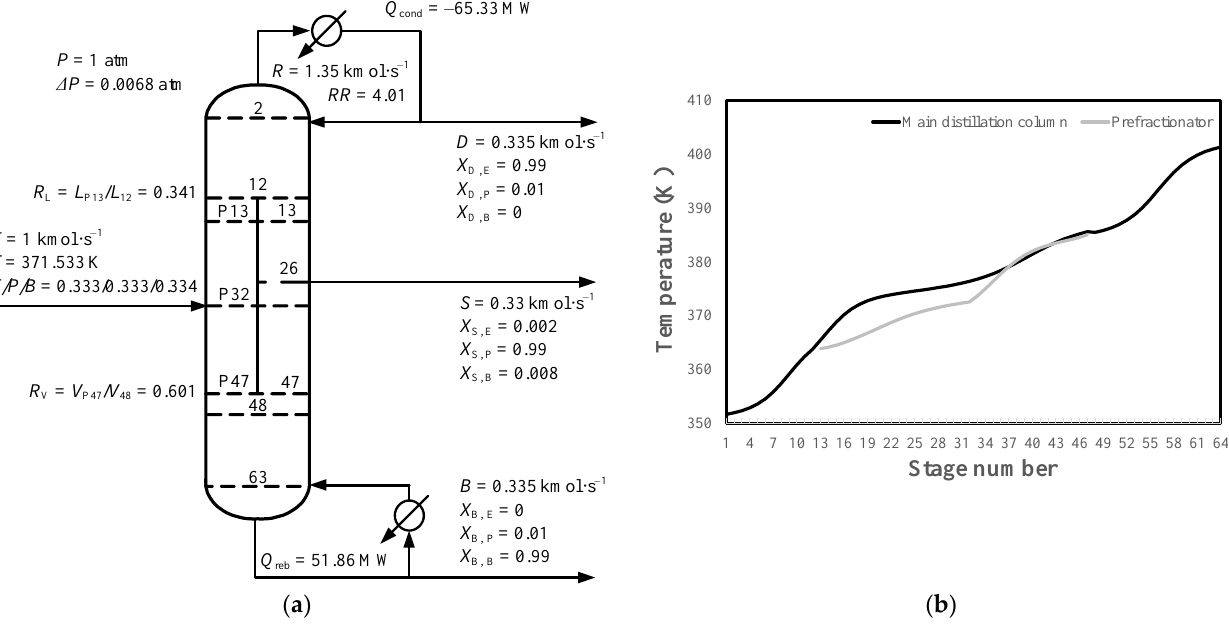
Figure 3. Example of the EPB Petlyuk DWDC: ( a ) steady-state design; ( b ) temperature profile.